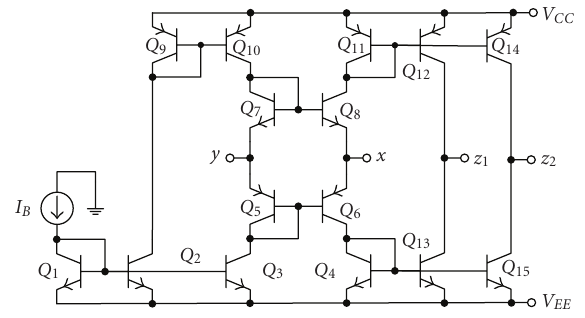
Figure 3: Internal construction of DO-CCCII.